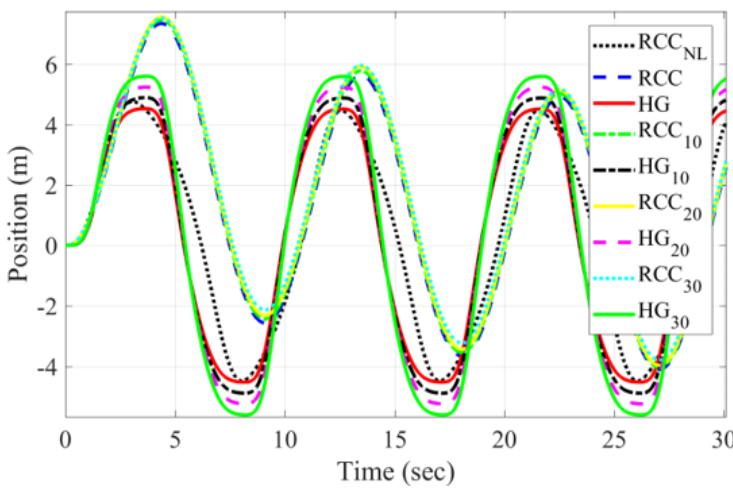
Figure 16. Buoy positions for the first 30 s of 100 s duration for all cases, respectively.